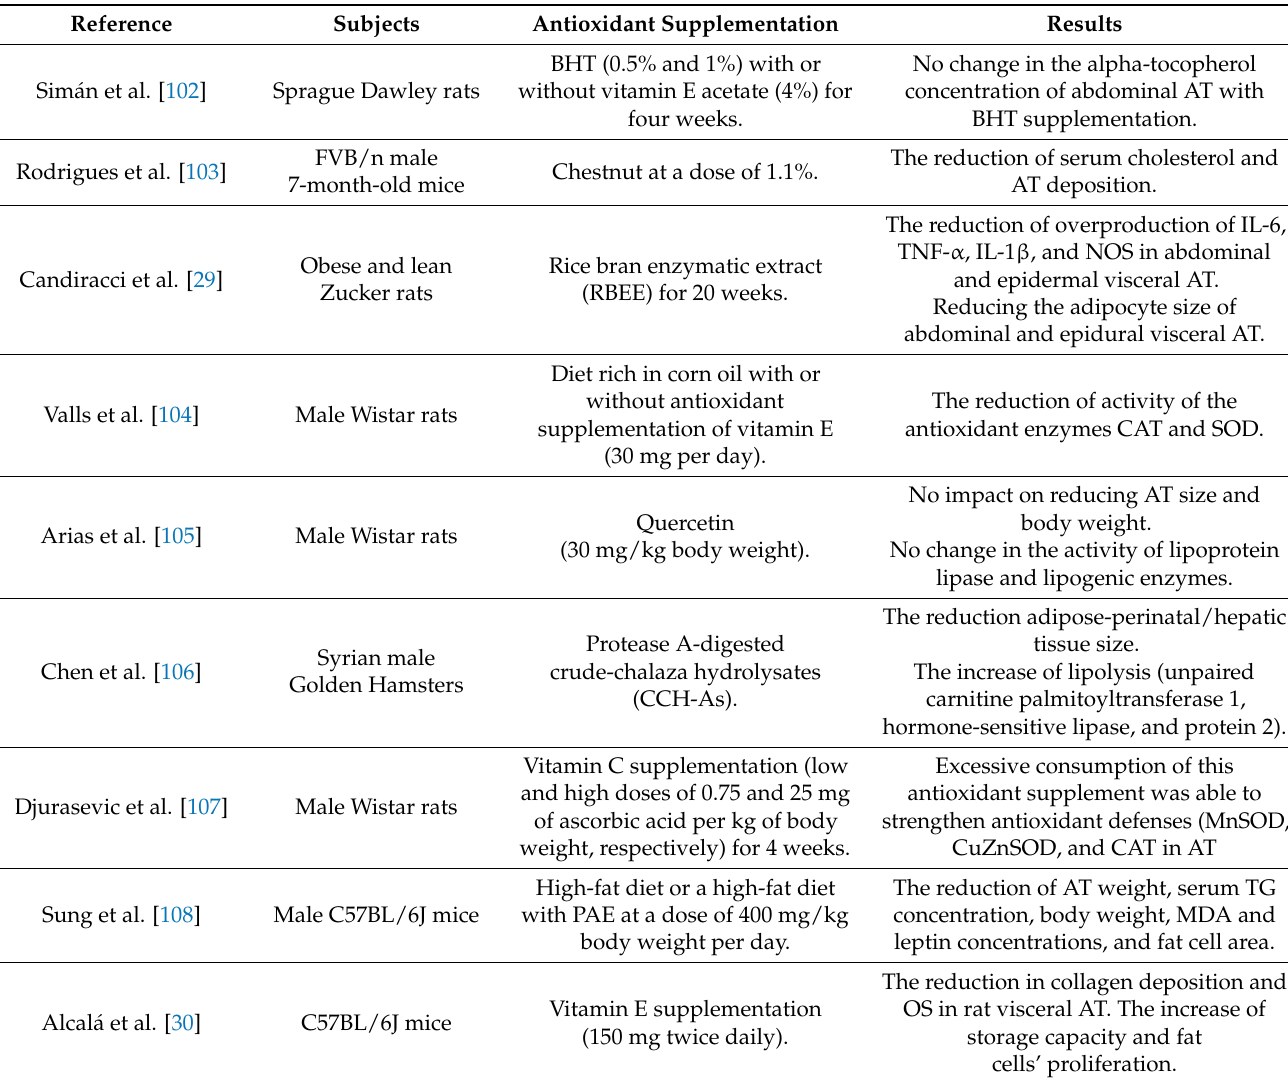
Table 1. The effect of antioxidant supplementation on obesity caused by oxidative stress